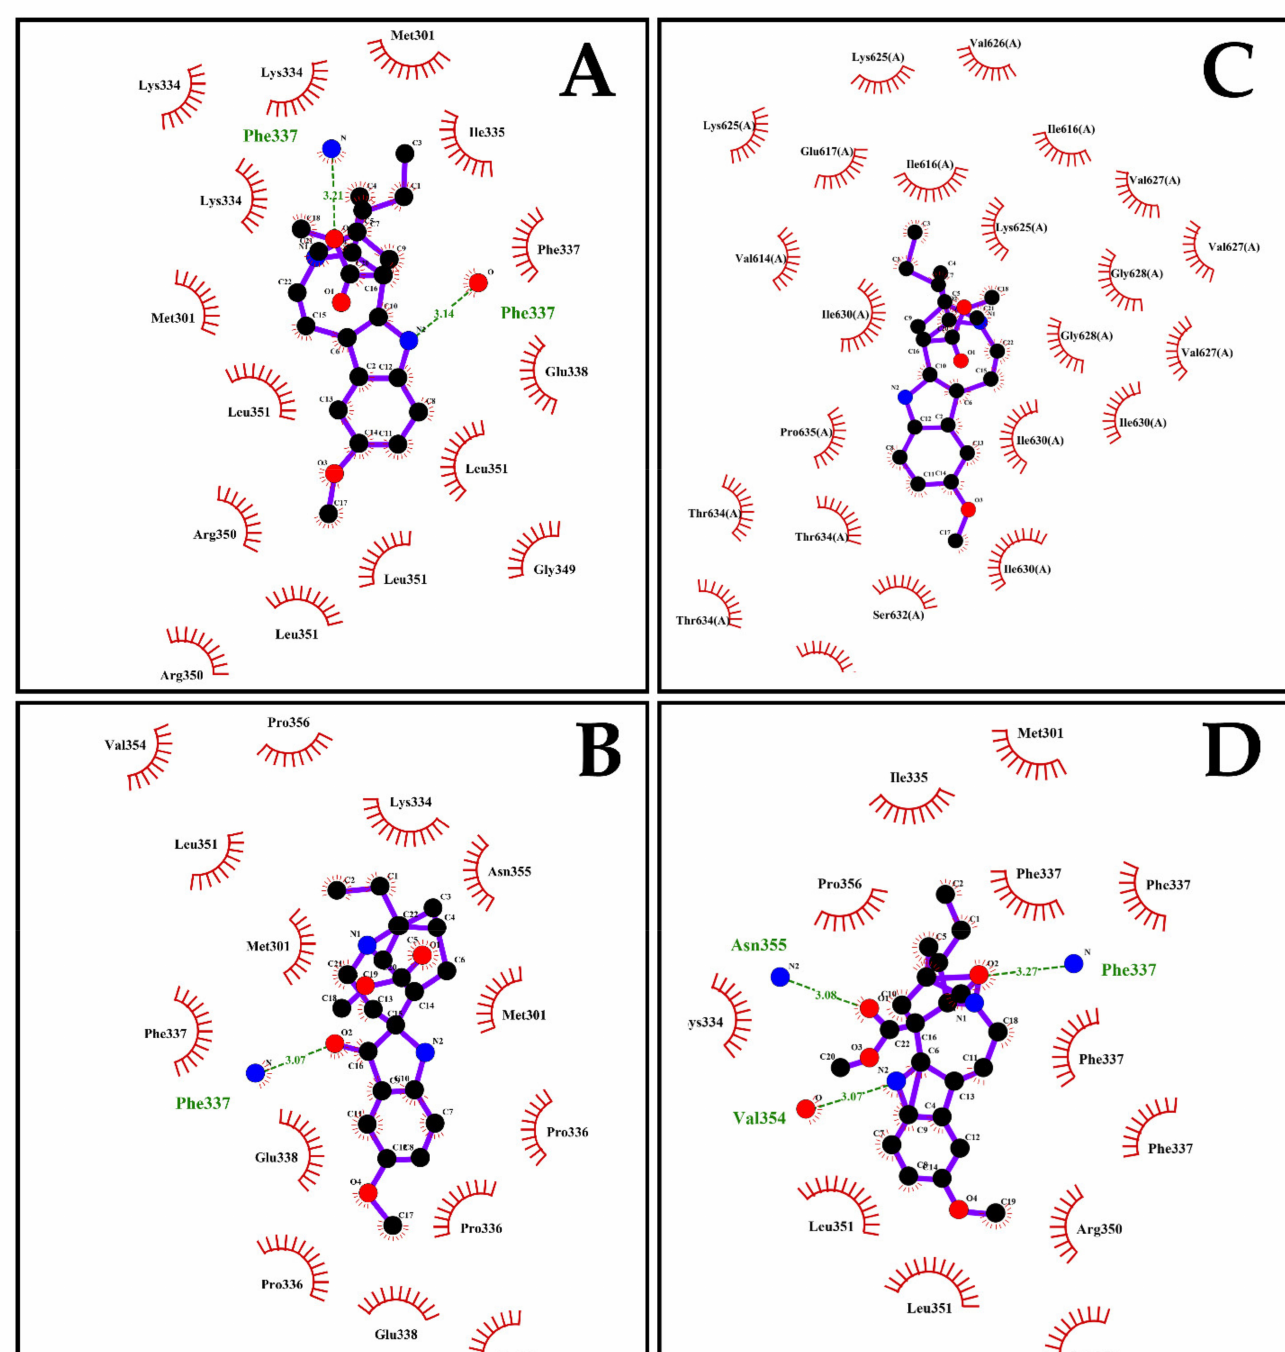
Figure 7. Molecular docking between compounds and DENV-2 envelope protein. The interactions formed between Domain III of DENV-2 Envelope protein and VOAC ( A ), VOAC-OH ( B ), rupicoline ( C ) and OXO-VOAC ( D ) were evaluated by LigPlot ® . Hydrogen bonds are shown in green and hydrophobic interactions in